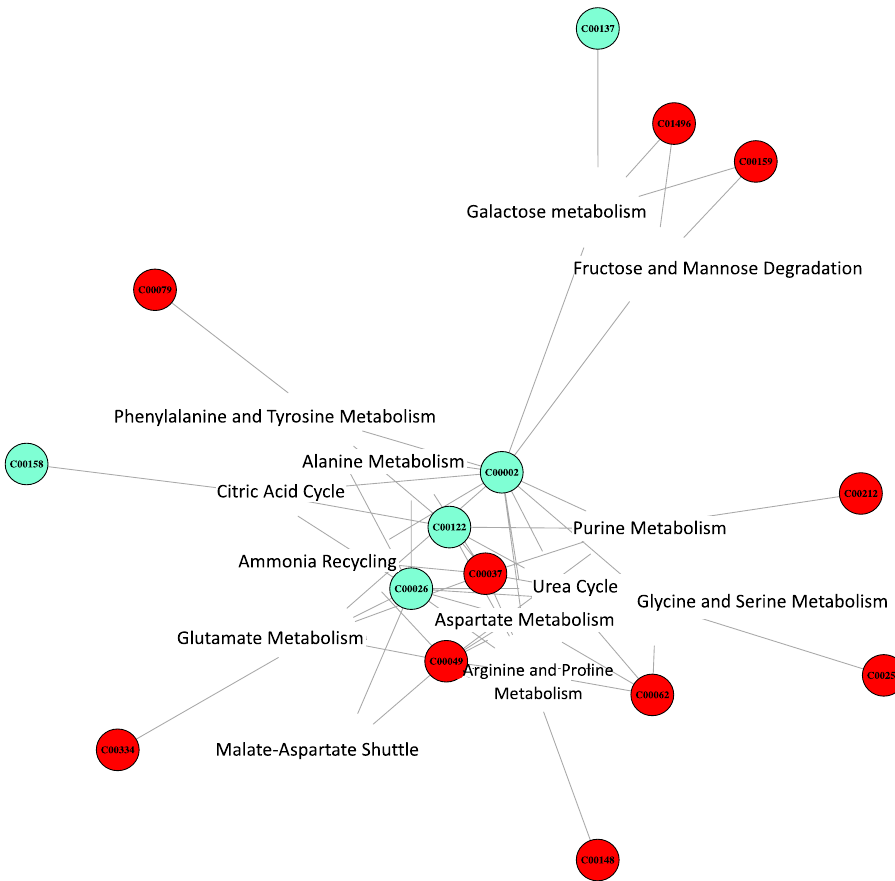
Figure 4. Network analysis of the metabolites and metabolic subsets identified by the MetaboAnalyst 4 software. Red and cyan circles correspond to metabolites which concentrations increase or decrease in plants grown in ammonium-rich amendments, respectively. Metabolites are identified by the corresponding KEGG code. Plot was created with MetaboAnalyst 4.0 software (https:// www. metab oanal yst. ca/ faces/ home.